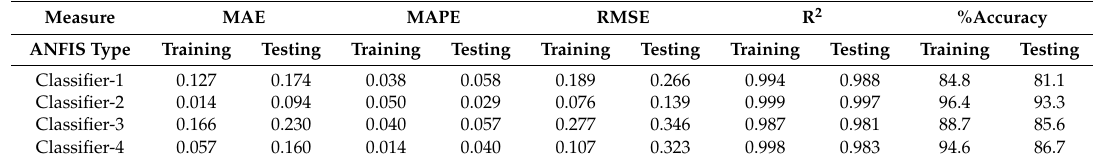
Table 8. Performance measures of the ANFIS